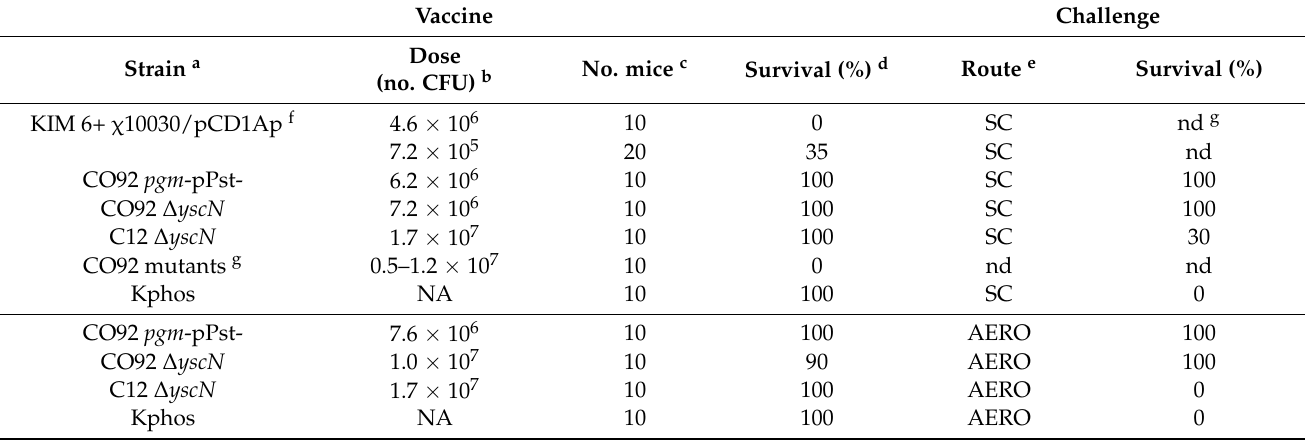
Table 3. Protection of BALB/c mice with Y. pestis vaccine strains against virulent Y. pestis. Vaccine